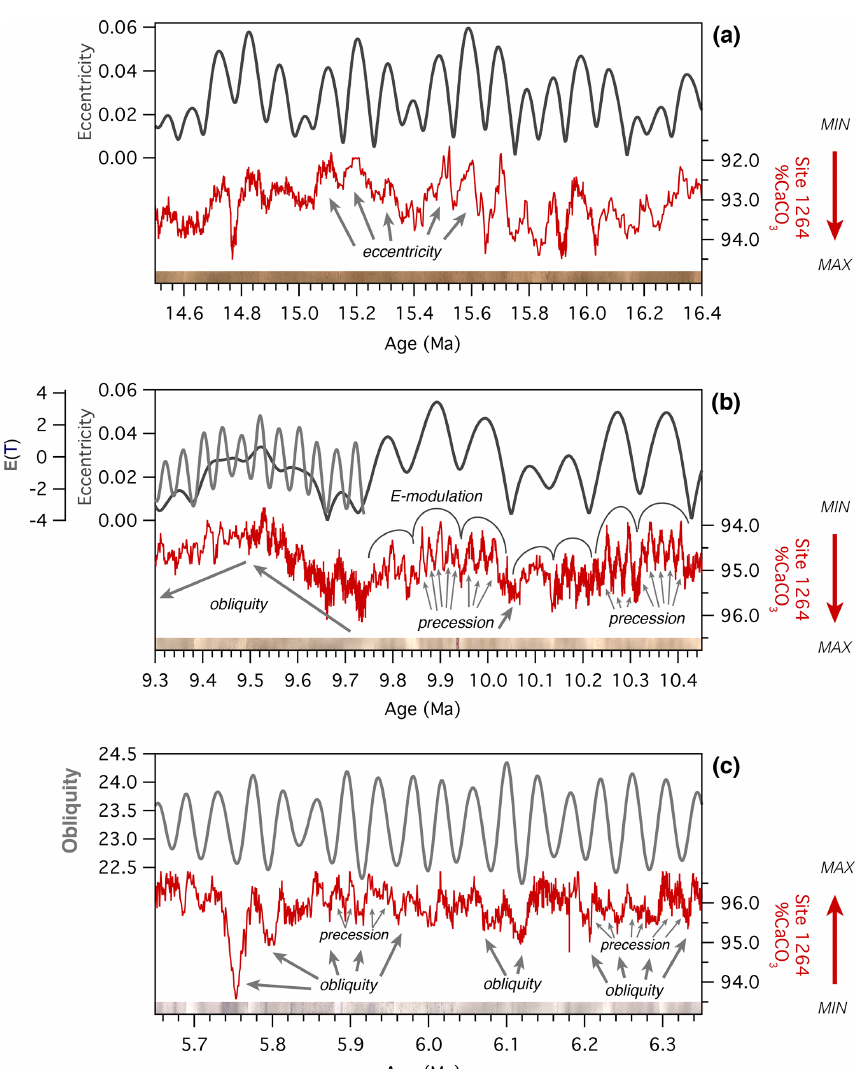
Figure 6. Zoomed-in panels highlighting the three distinctly different orbital controls on Southeast Atlantic CaCO 3 deposition. (a) Example of strong eccentricity ( E ) pacing present between 30 and 13Ma. (b) Example of the prevalent eccentricity-modulated precession pacing present between 14 and 8Ma. (c) Example of the pervasive obliquity forcing present between 8 and ∼ 3.3Ma. An example of stronger obliquity appearing in a 2.4Myr eccentricity minimum, when eccentricity-modulated precession is muted, is also shown in (b) . CaCO 3 minima correlate with eccentricity maxima between 30 and 8Ma (a, b) . Between 8 and 0Ma, CaCO 3 maxima correlate with obliquity maxima (c)